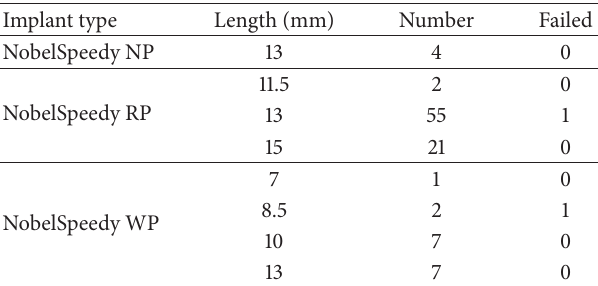
Table 1: Quantitative data concerning size and number of the successful and failed implants used in 14